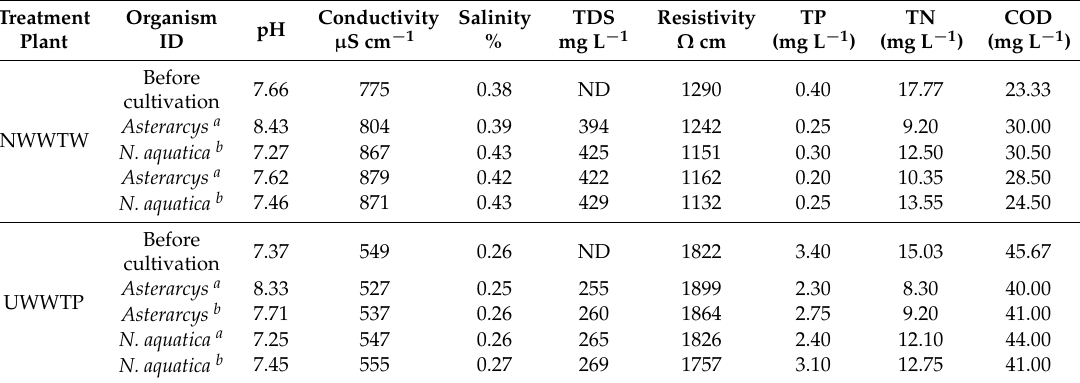
Table 1. Physico-chemical profiles of treated pre-chlorinated wastewater effluent before and after cultivation with